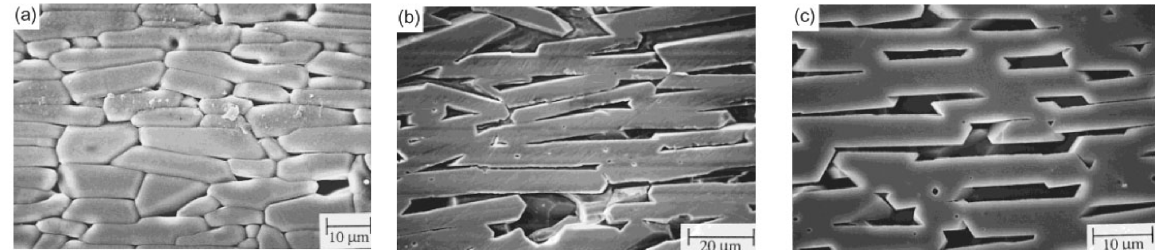
Fig. 16 Morphologies of liquid phase sintered α-Al 2 O 3 specimens using 4 wt% oriented template grains and different amount of CaO–SiO 2 additive: (a) 0.5 wt%, (b) 1 wt%, (c) 5 wt%. Reproduced with permission from Ref. [162], © John Wiley and Sons 2005.